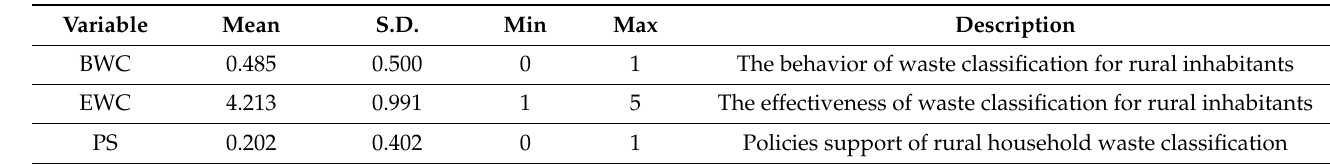
Table 2. Core variables’ definition and descriptive statistics.